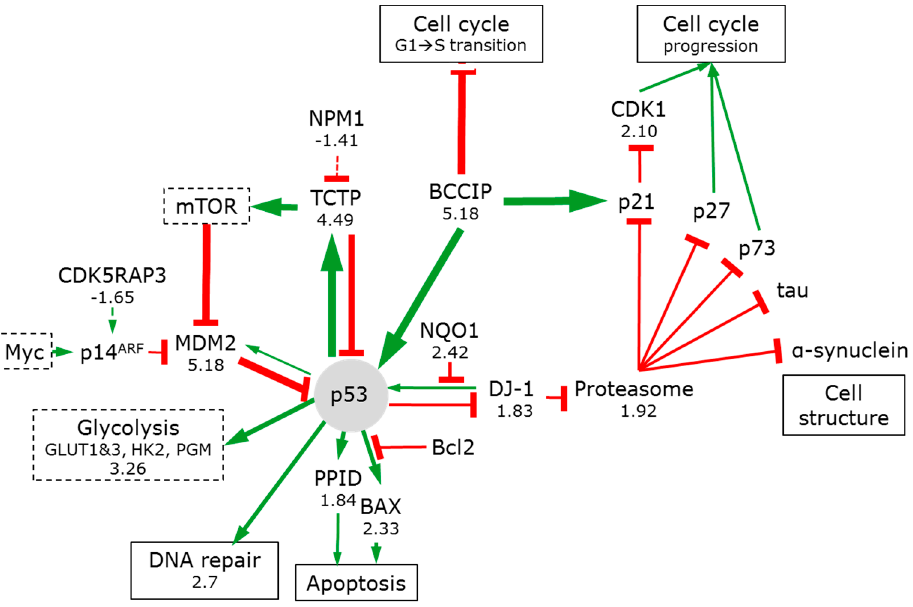
Figure 8. p53 signalling in 3D spheroids. See legend to Figure 4 for nomenclature.